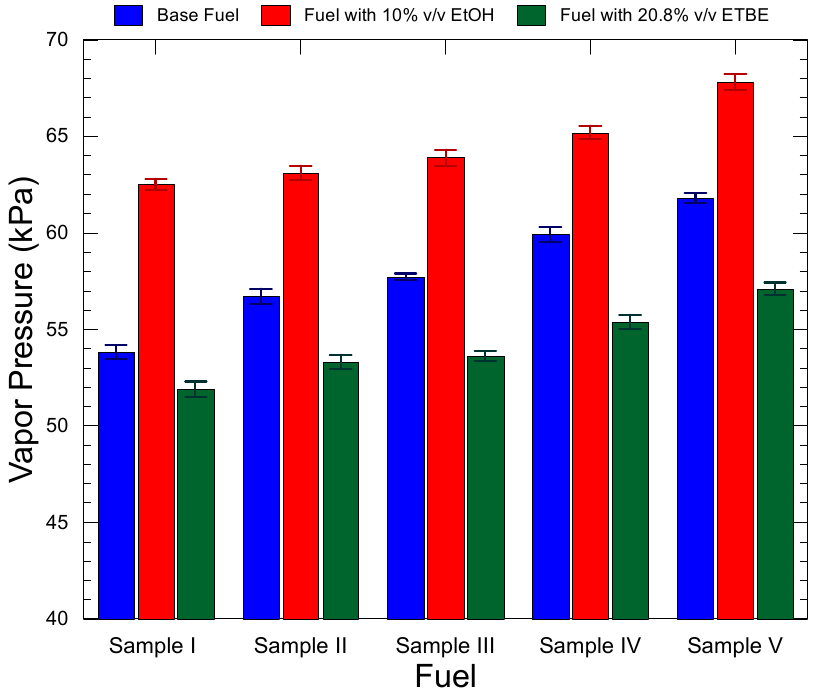
Figure 2. Vapor pressure of base gasoline blends/blends with bio-ethanol/blends with bio-ETBE.